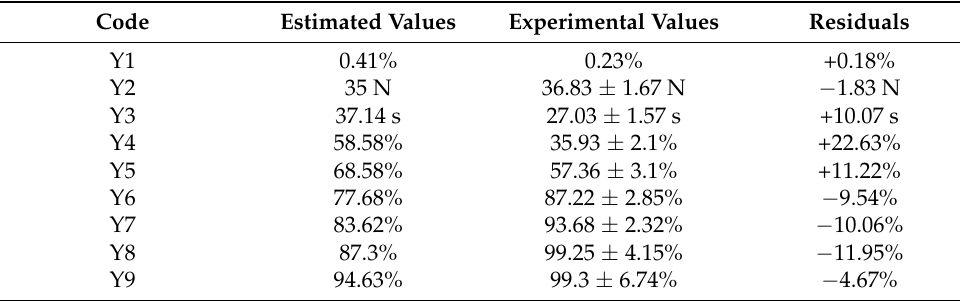
Table 9. Estimated versus obtained